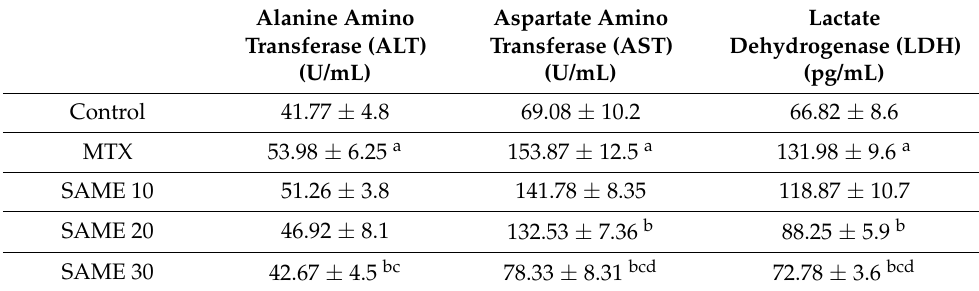
Table 3. Effects of SAME Pre-treatment on serum indices of hepatotoxicity in MTX-induced hepato- toxicity in mice. Aspartate Amino Alanine Amino Transferase (AST) Transferase (ALT) (U/mL) (U/mL)